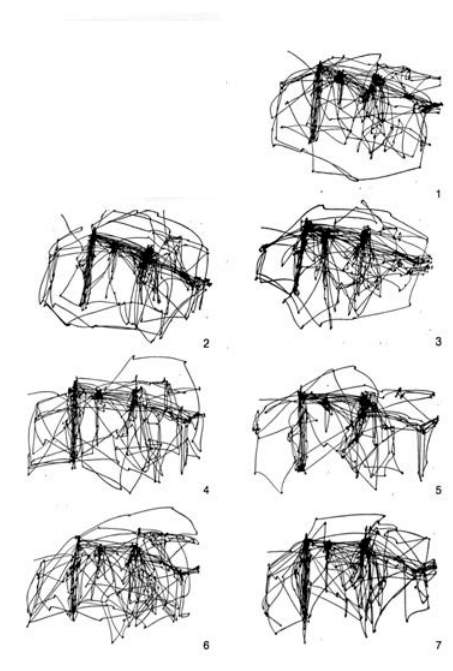
Figure 13. Seven recordings of eye movement, both eyes free-viewing, from a single subject, at 1 to 2 day intervals, in chronological order. (From Yarbus